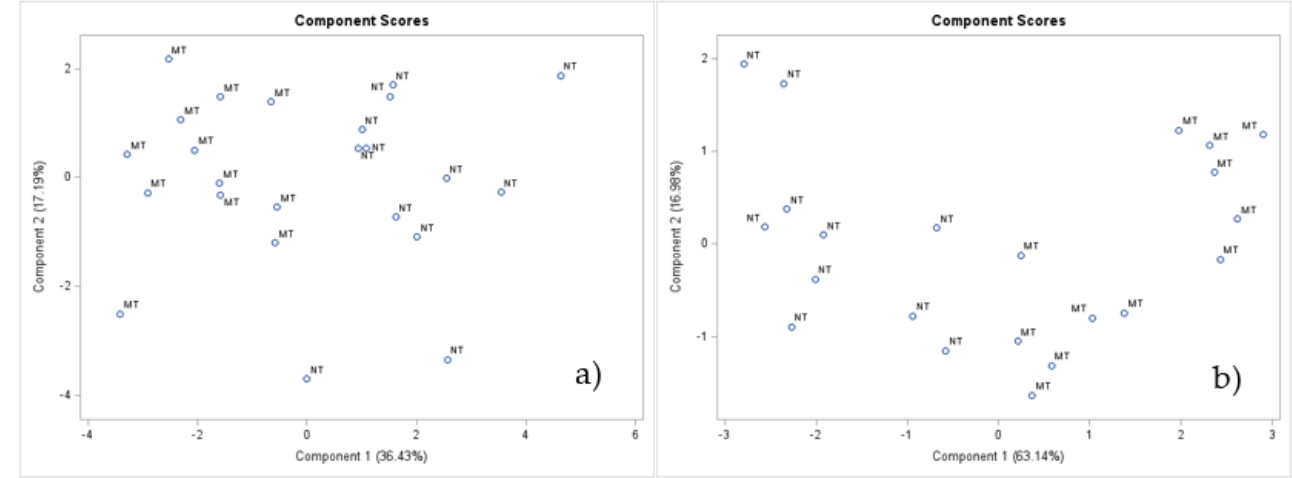
Figure 1. Score plots of the first two principal components extracted in the analysis carried out on the set of chemical ( a ) and physical ( b ) soil indicators. MT = minimum tillage; NT = no-tillage.